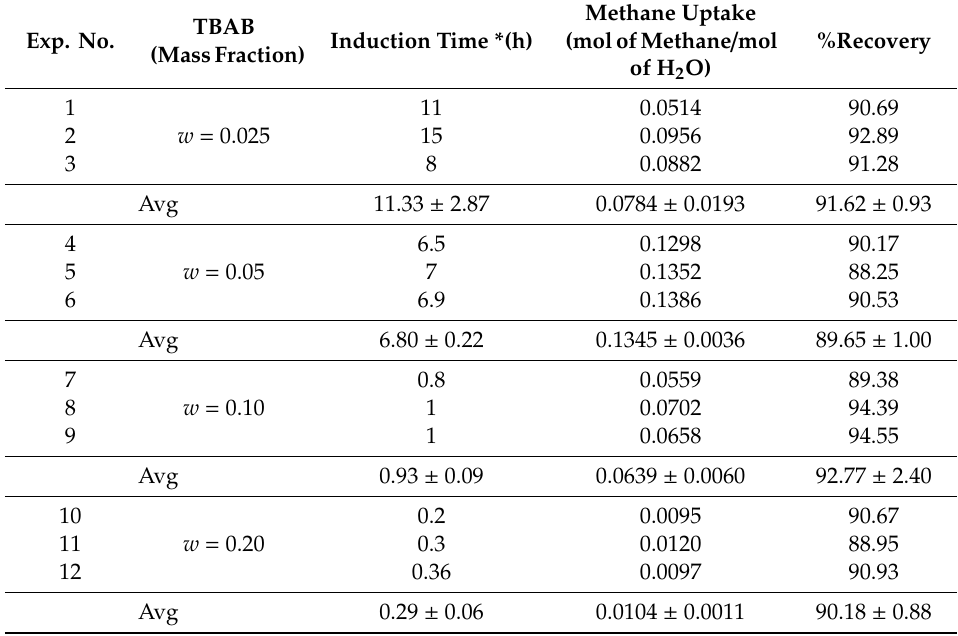
Table 1. Methane hydrate formation in the presence of di ff erent tetra-n-butyl ammonium bromide (TBAB) concentrations at 2.5 ◦ C and 8 MPa.